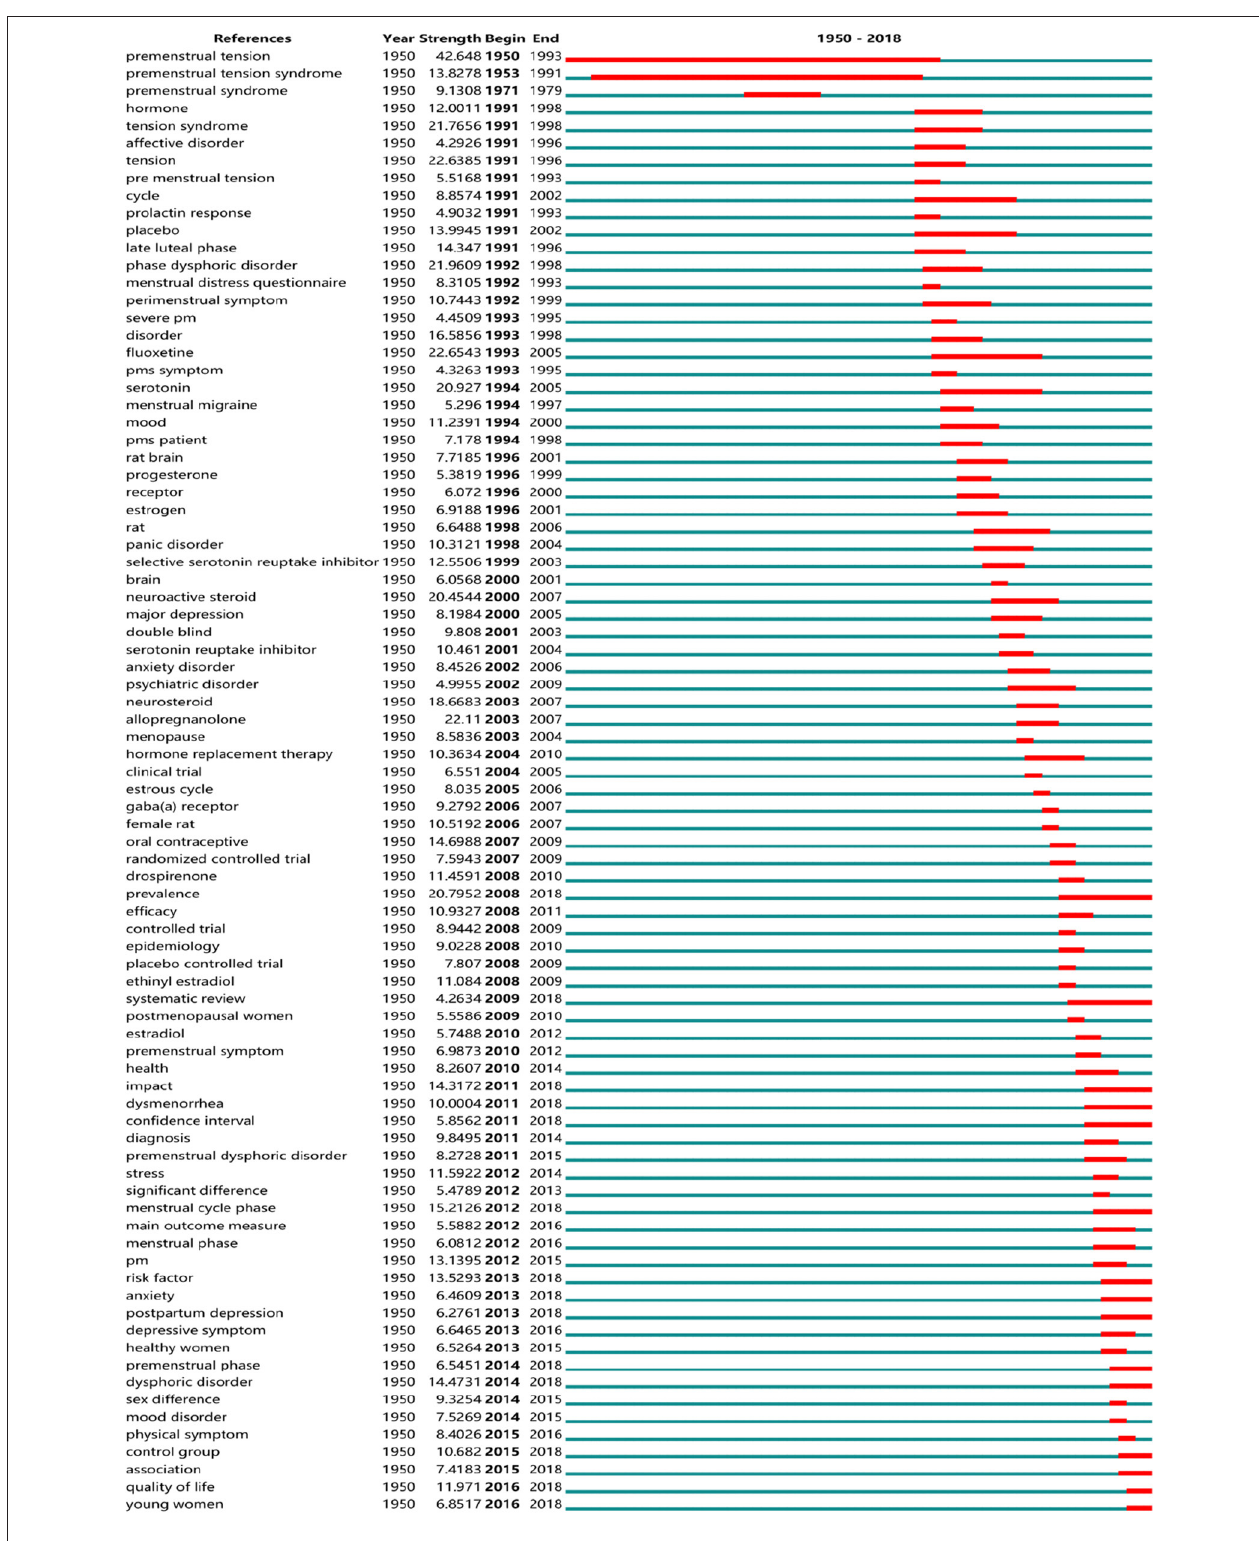
FIGURE 10 | Top 84 keywords with the strongest citation bursts.